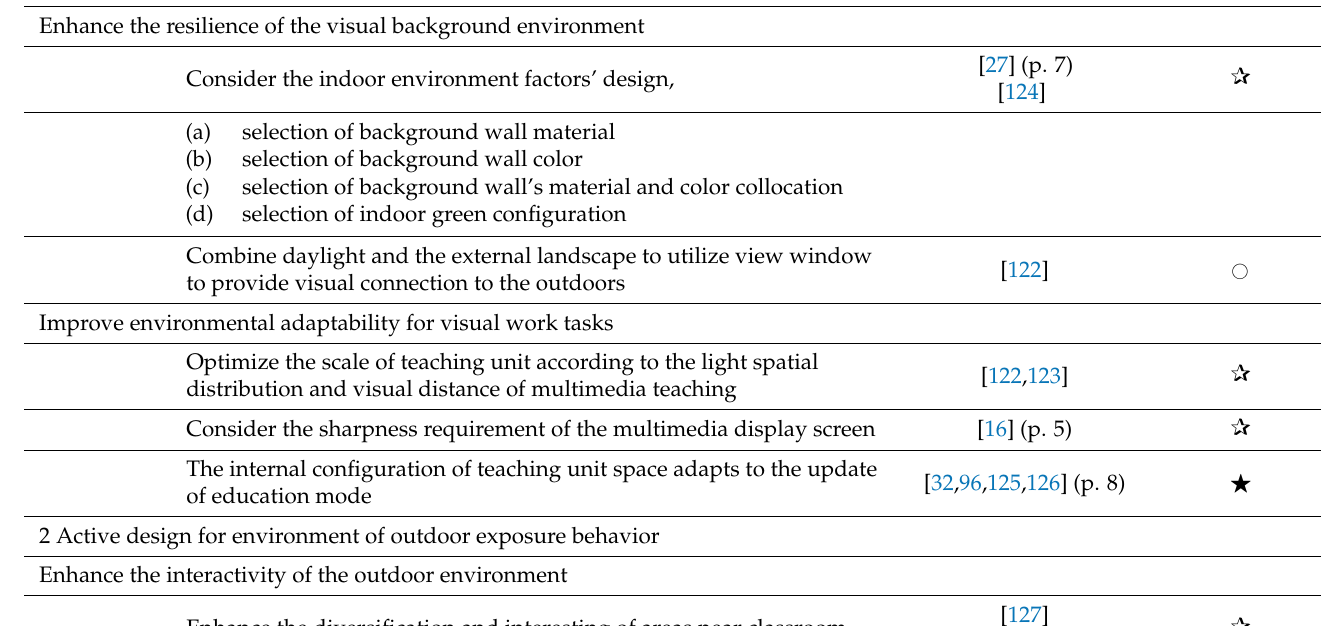
Table 3. Visual health design guidelines for school architecture.